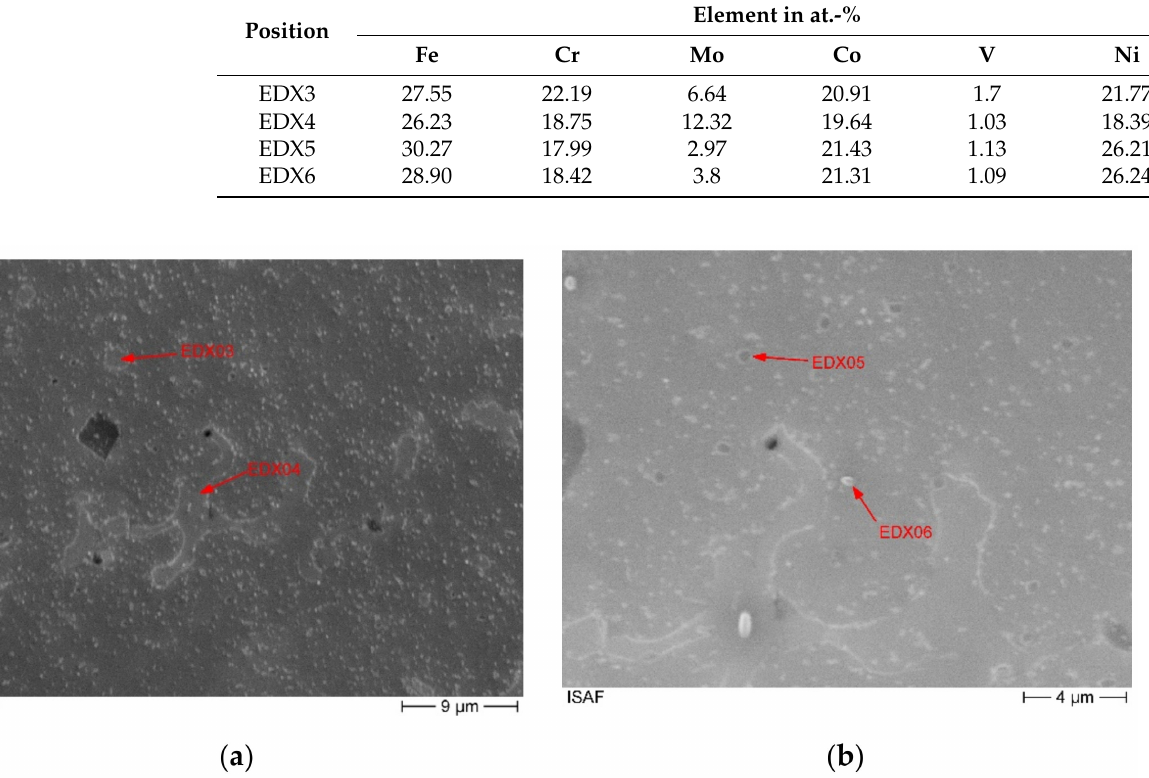
Figure 5. SEM images of different magnifications ( a ) 2500 × , ( b ) 5000 × of the alloy with marks for EDX measurements of two main